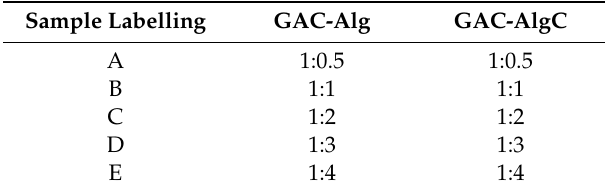
Table 1. Samples of granular activated carbon–alginate (GAC–Alg)- and granular activated carbon– alginate–chitosan (GAC–AlgC)-immobilised beads v / w